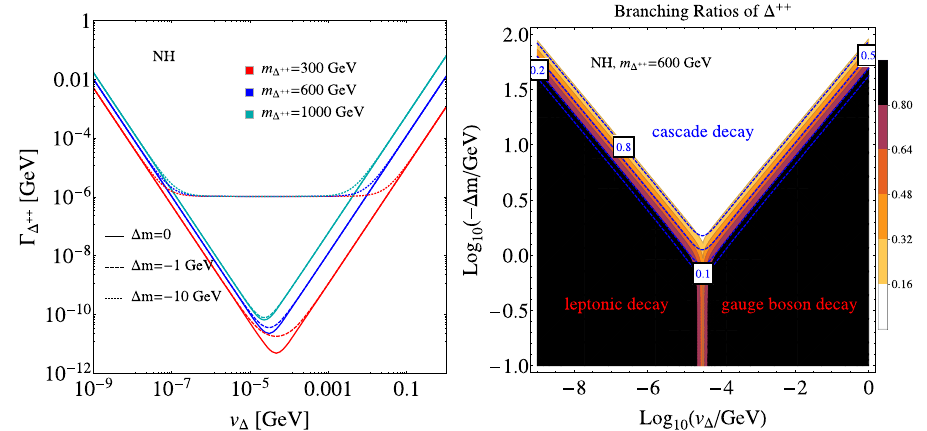
Fig. 4 Left: total decay width of (cid:2) ±± defined in Eq. (35) as a function of the quadruplet VEV v (cid:2) for m (cid:2) ±± = 300, 600 , 900 GeV for the NH. The solid, dashed, dotted curves correspond to (cid:2) m = 0, − 1 , − 10 GeV, respectively. Right: decay branching ratios of (cid:2) ±± in the plane of log 10 (v (cid:2) / GeV ) and log 10 ( − (cid:2) m / GeV ) for m (cid:2) ±± = 600 GeV and Fig. 5 Impact of (cid:2) m on the partial decay widths of (cid:2) ±±± (cid:8) ± into W ± (cid:8) ± and W ± W ± W ± i j in the left and right panels, respectively. Benchmark values of | (cid:2) m | = 1, 10 GeV are considered